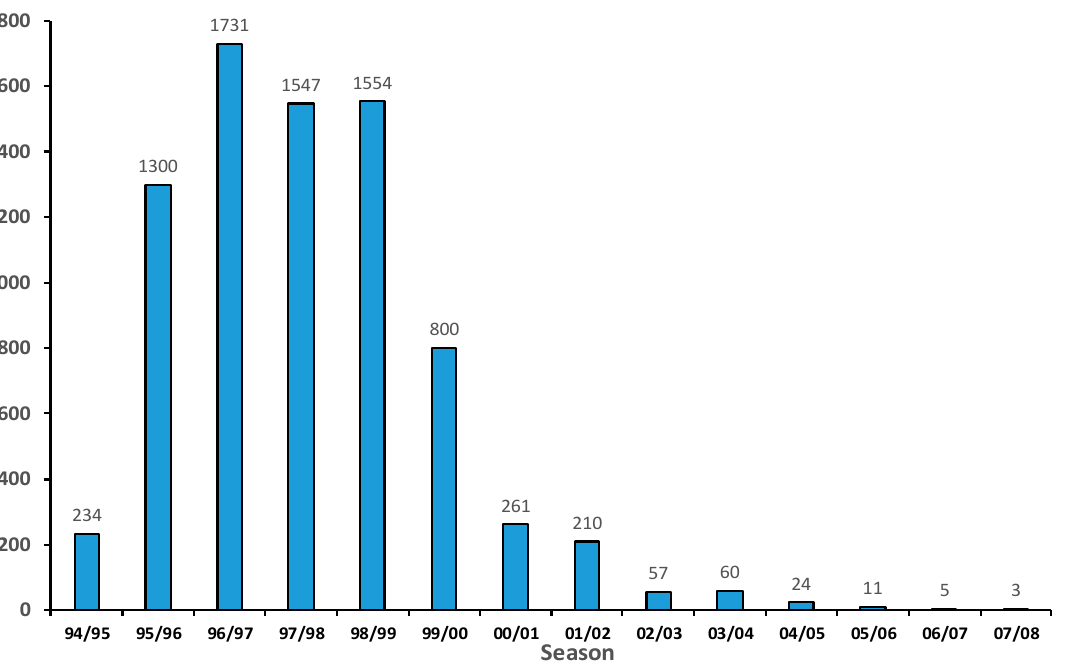
Figure 6. The total number of all carp caught in Lake Crescent from 1995 to 2007, with the last carp caught in 2007.